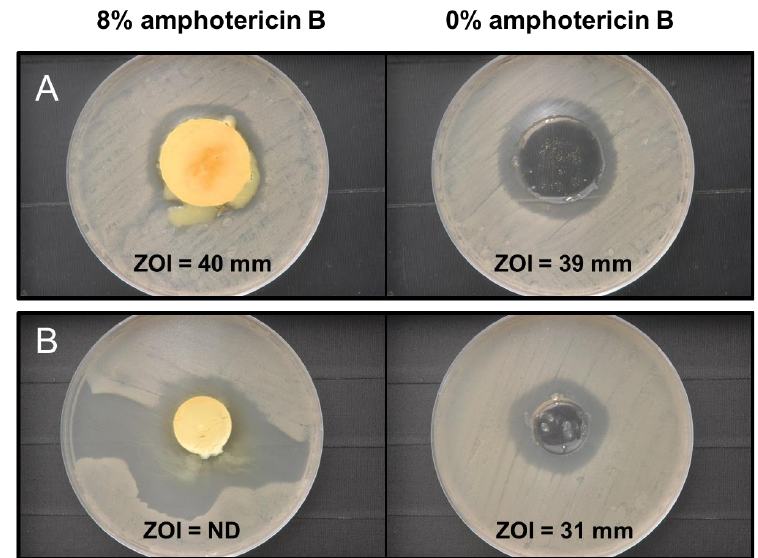
Figure 9. Modified disk diffusion assay results involving Candida albicans for 8% and 0% amphoter- icin-B-loaded Gantrez TM microneedles; ( A ) partially solvated microneedles; ( B ) fully solvated mi- croneedles. ZOI = zone of inhibition.